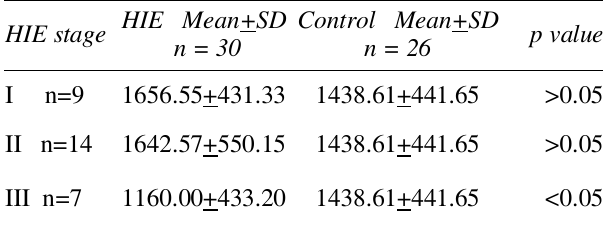
Table 1: Total antioxidant level (µmol/L) in different stages of hypoxic ischemic encephalopathy (HIE).